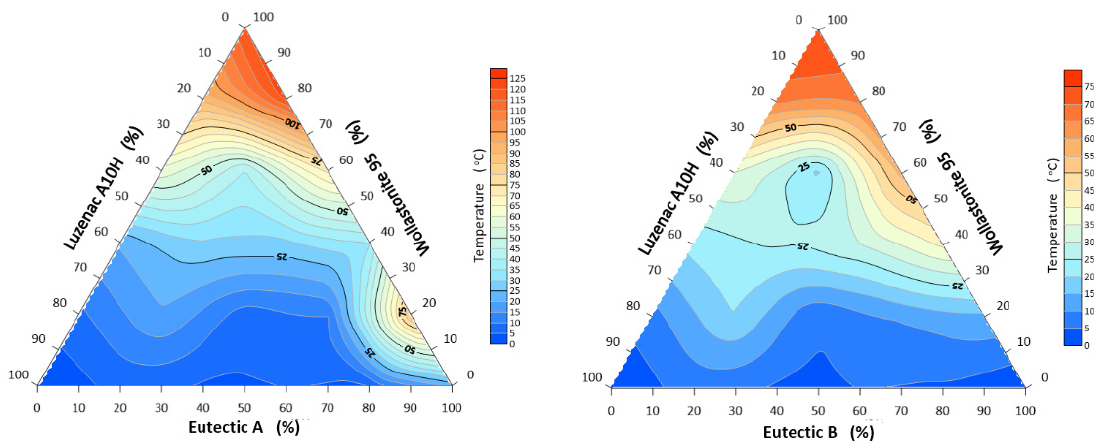
Figure 6. System melting interval: A/B-eutectic–Luzenac A10H–Wollastonite 95. For the system B-eutectic–talc–wollastonite, the narrowest interval of 4 °C was rec- orded for the composition of 80% wollastonite and 20% talc. For the 100% B composition point, the widest melting interval of 75 °C occurred.